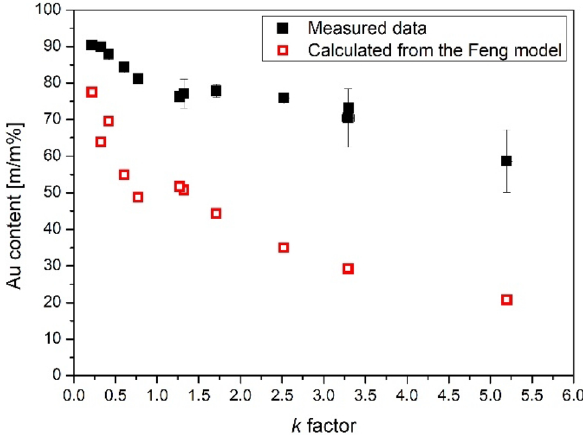
Figure 4. Comparison of the experimentally determined and the predicted, according to Ref. 31 , Au content of the generated BNPs as a function of the k